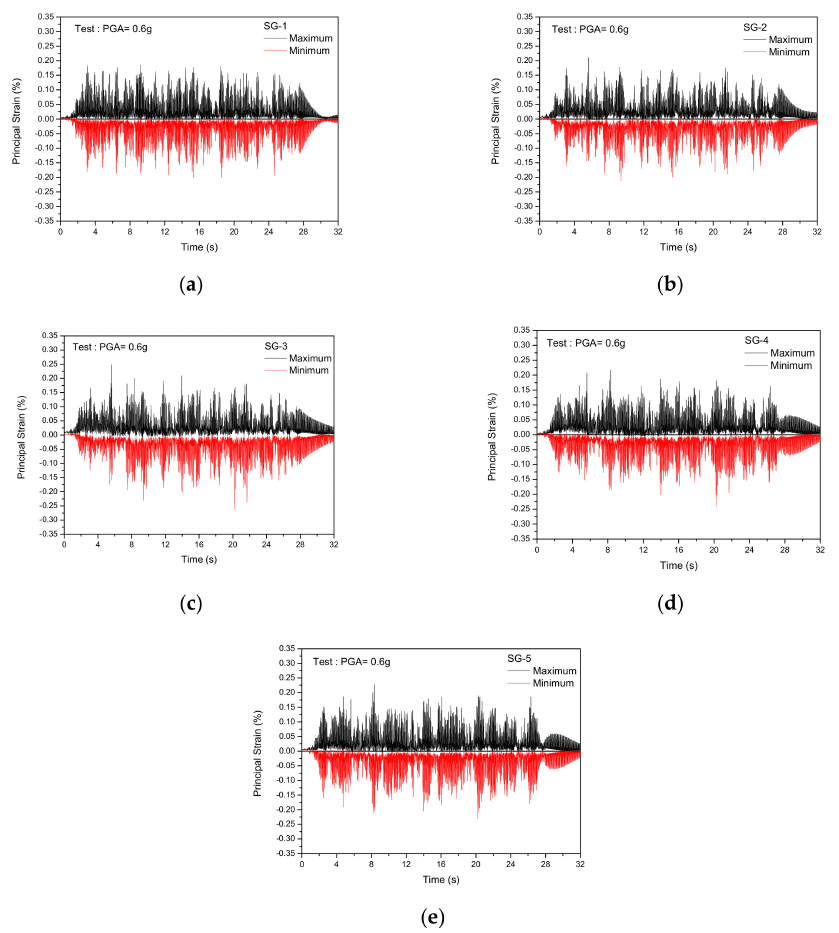
Figure 9. Test results of principal strain time history responses for PGA = 0.6 g: ( a ) SG-1; ( b ) SG-2; ( c ) SG-3; ( d ) SG-4; ( e )